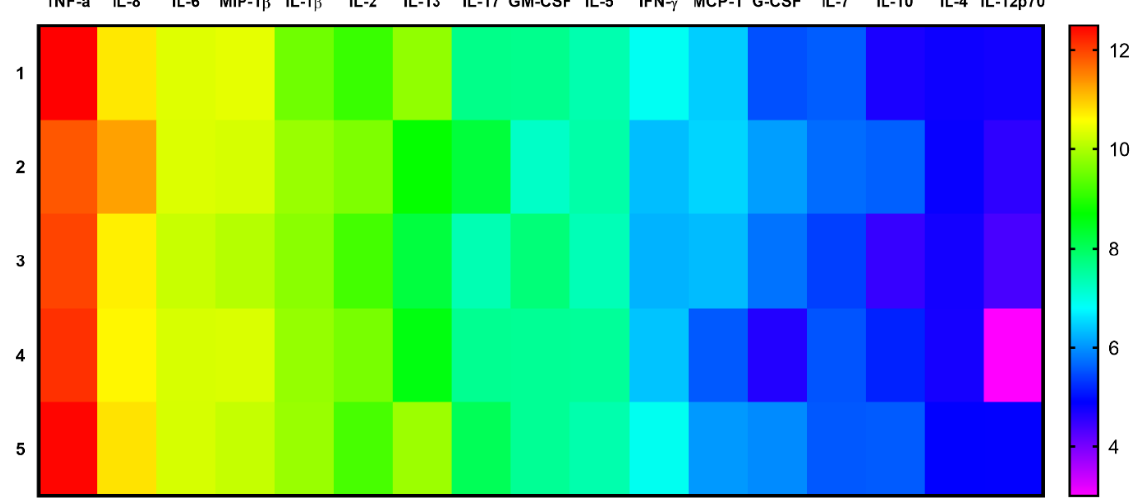
Figure 8. Heat map of cytokine concentrations in control cultures (without GO) of Th17-polarized helper T-cells. Note: n = 5; Cytokine concentrations are shown as natural log-values; IL-1 β and IL-6 were introduced into the culture medium in accordance with Th17 polarization method.